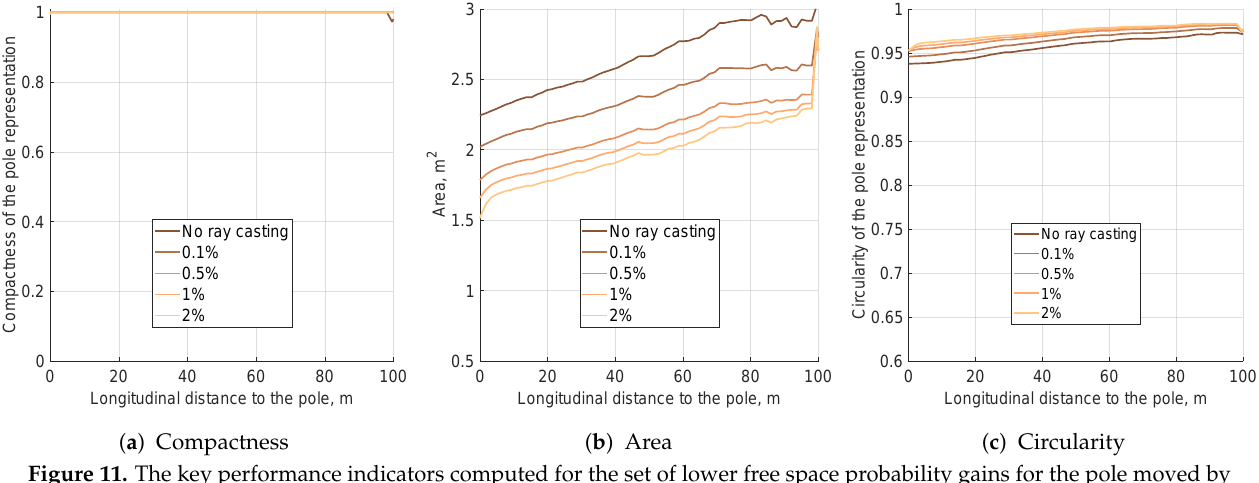
Figure 11. The key performance indicators computed for the set of lower free space probability gains for the pole moved by 10 m laterally per step with the application of a 2D Gaussian sensor model. The scaling of this figure is the same as that of all other simulation KPI plots.